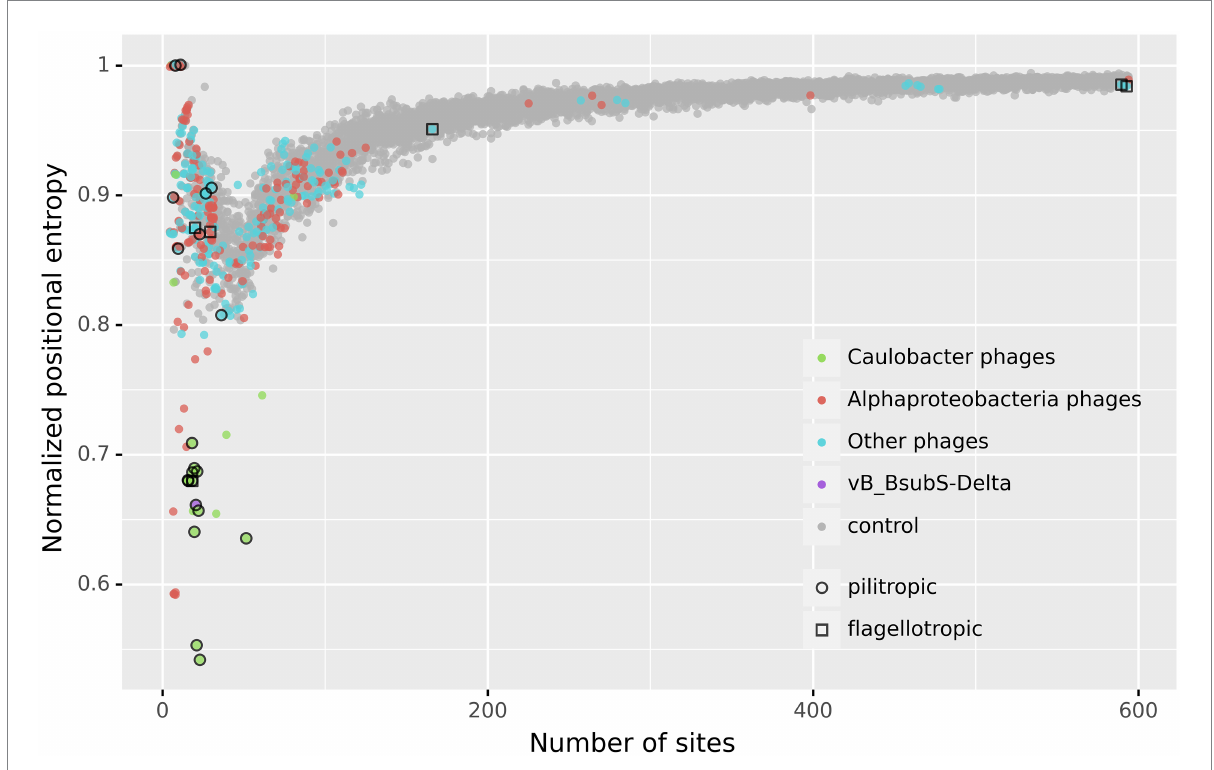
FIGURE 6 Normalized Positional Entropy vs. number of identified CtrA-binding sites. Each filled circle indicates the normalized positional entropy of the genome as a function of the number of putative binding sites detected in its genome sequence. Uniform jitter was applied for clarity. Color coding in filled circles denotes, respectively, Caulobacter phages (green), other Alphaproteobacteria phages (red), vB_BsubS-Delta (purple), all the other analyzed phages (cyan) and the negative control (gray). The negative control was obtained by generating 10 random positional distributions for each possible number of sites and computing their normalized positional entropy (for a total of 5,890 data points). Open circles designate known pilitropic phages, and open squares denote known flagellotropic phages (Supplementary Table